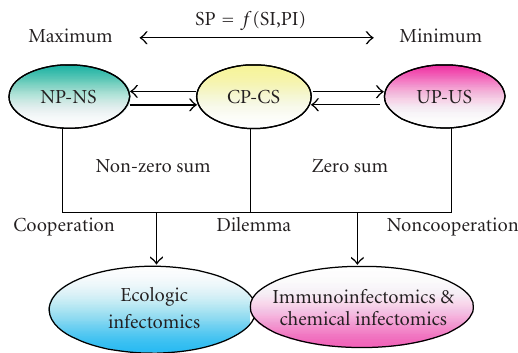
Figure 2: A continuum model of host-microbe interactions cou- pling with infectomic approaches to dissect the problems in micro- bial